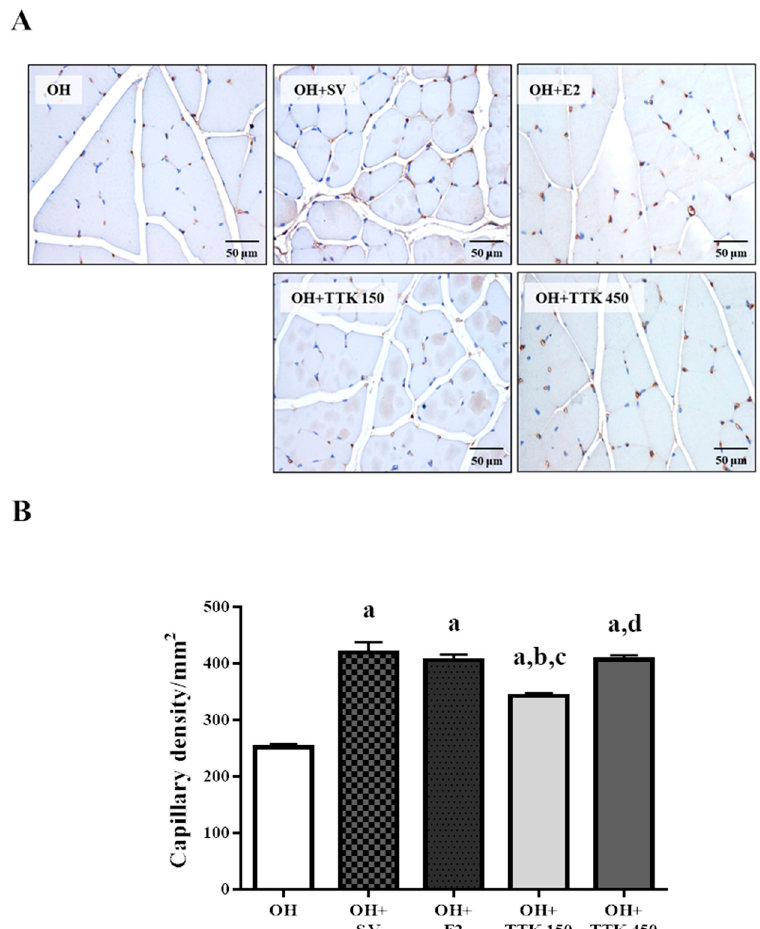
Figure 5. E ff ects of TTK on vascular formation in ischemic limb. ( A ) Representative micro-photographs of the section of ischemic hind-limb muscles stained histochemically for CD-31, magnification 400 × . ( B ) Quantitative analysis of capillary density in ischemic hind-limb muscles. Data are presented as mean ± SD (n = 7). a p < 0.05 vs. OH, b p < 0.05 vs. OH + SV, c p < 0.05 vs. OH + E 2 , d p < 0.05 vs. OH + TTK 150.